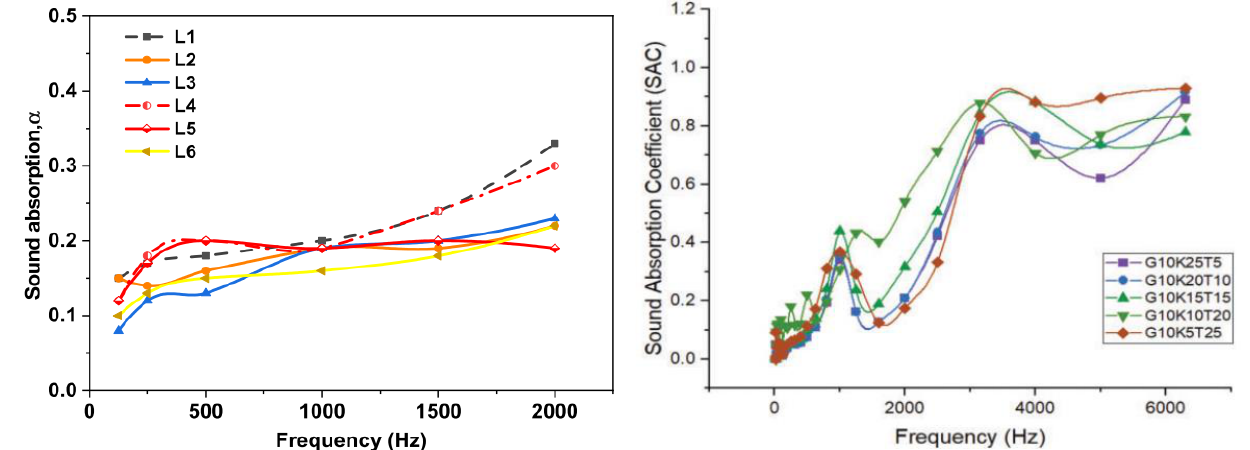
Figure 6. Sound absorption coefficients of polymer composites (Adapted from the references [110,112]).